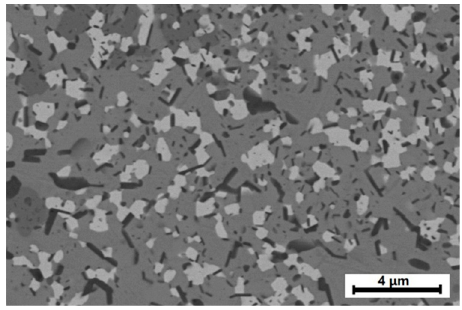
Figure 2. SEM images of the cobalt-based alloy powders after milling for 10 h, ( a ) morphology of the milled powders, ( b ) back-scattered electron (BSE) image of one particle, and ( c ) element mapping image of energy dispersive X-ray spectrometry (EDS) results.